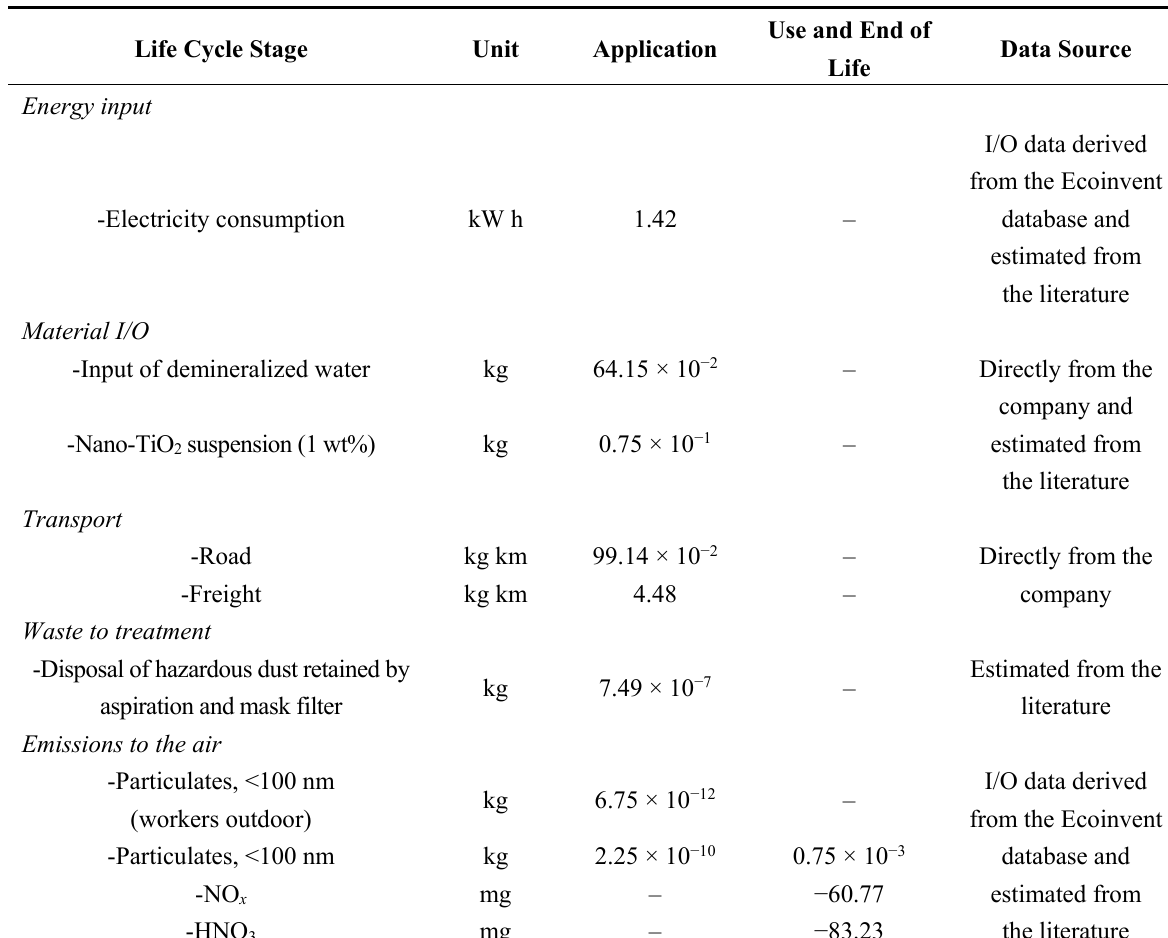
Table 1. Inventory data of the nano-TiO 2 coating on